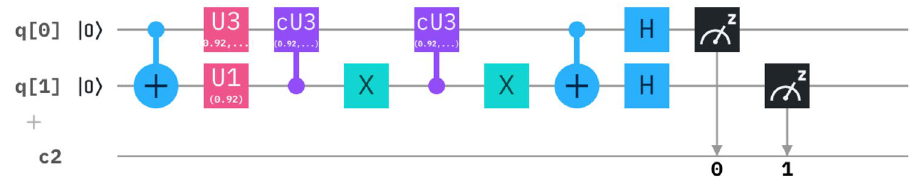
Figure 5. Measurement bases for the calculation of average values of <σ x σ x > for N=2 in circuit.